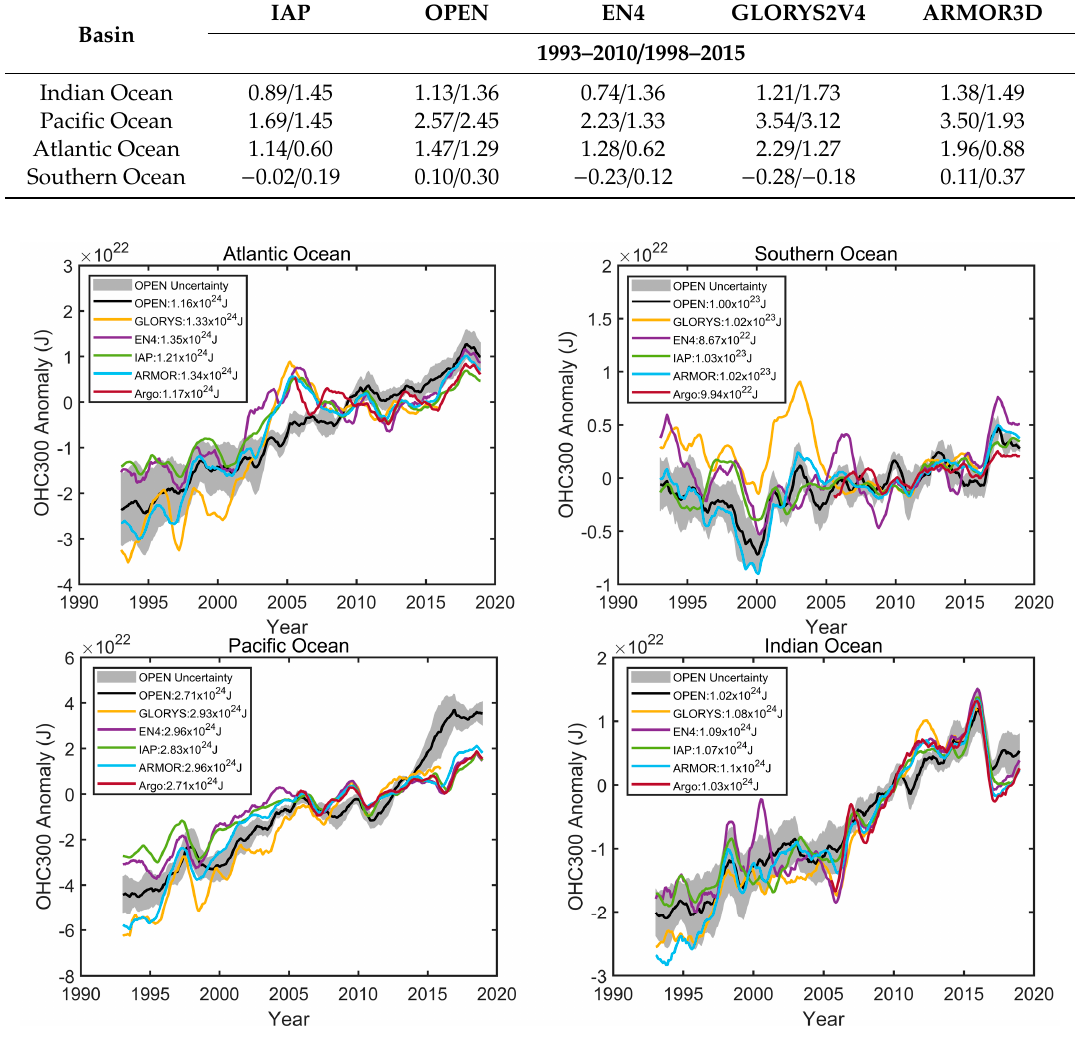
Table 3. Warming rates of OHC300 for different ocean basins in ×10 22 J/decade.